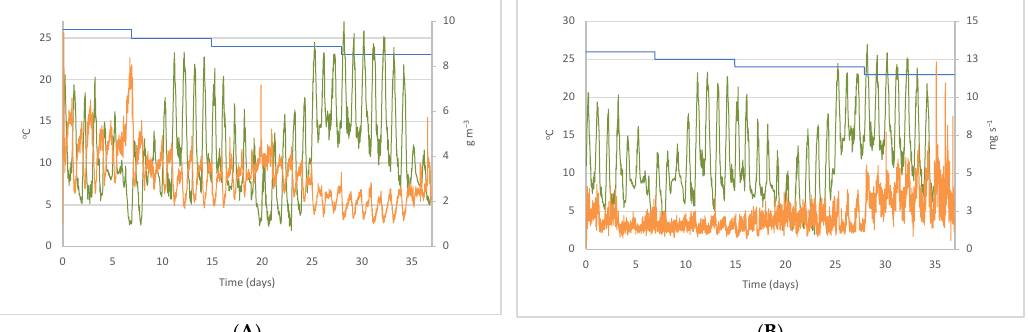
Figure 3. Evolution throughout the cycle of outdoor temperature, – T OUT (°C) and setpoint temperature – T S (°C) with ( A ) CO 2 concentration, – C CO2 (g m − 3 ), and ( B ) CO 2 emissions per animal, – E CO2 (mg s − 1 ).